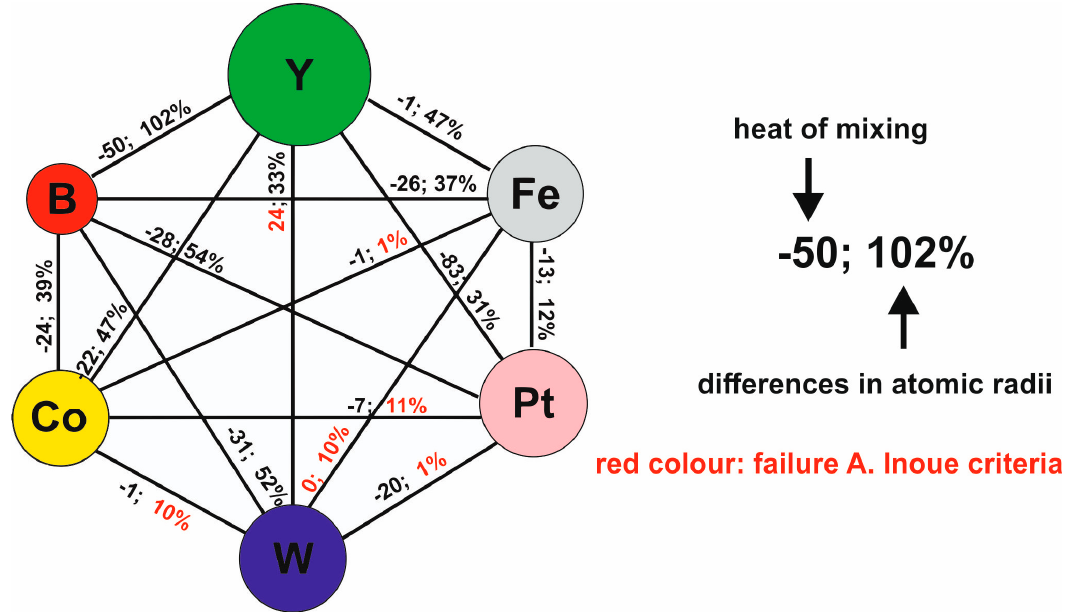
Figure 6. Diagram showing the di ff erences in atomic radii and enthalpy of mixing between the components of the studied materials.